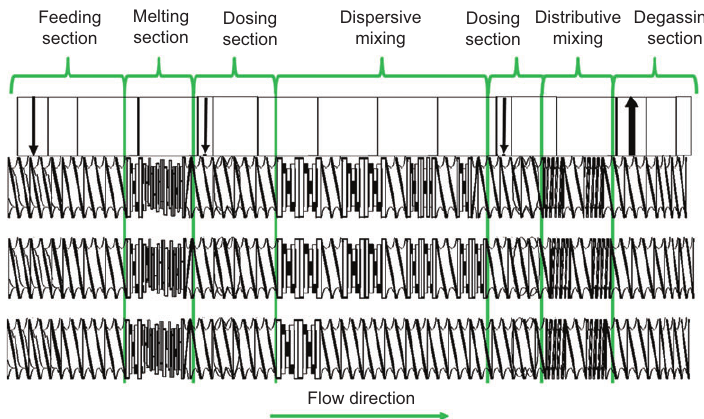
Figure 2 Screw configurations used in the experimental setup.